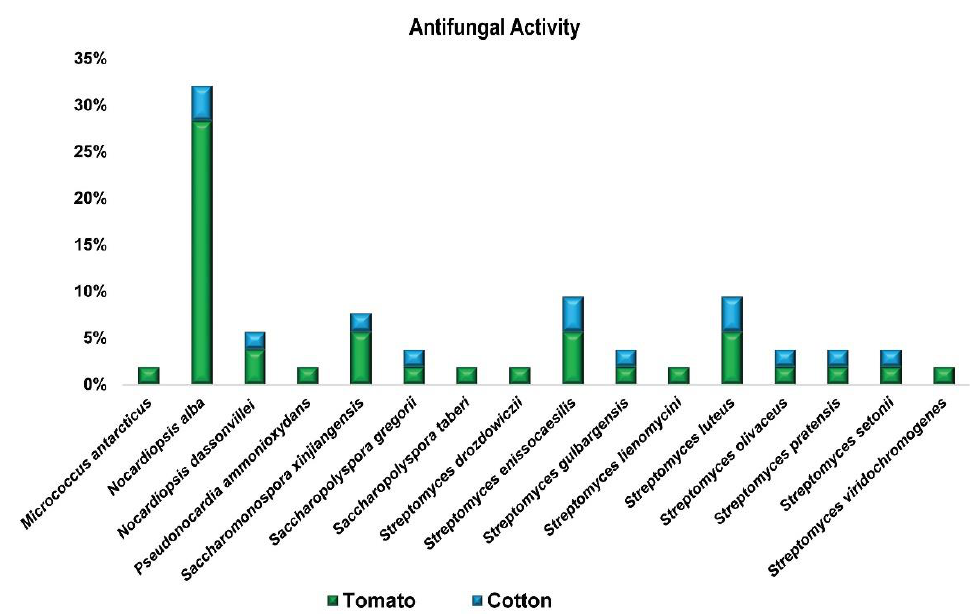
Figure 2. Antifungal activity of endophytes against two common fungal pathogens, F1: F. oxysporum , F2: V. dahliae . Each ring, F1 and F2, represents the total number of strains with antagonistic activity against the fungal pathogen and is divided into different colors based on the proportion of each species to that total.